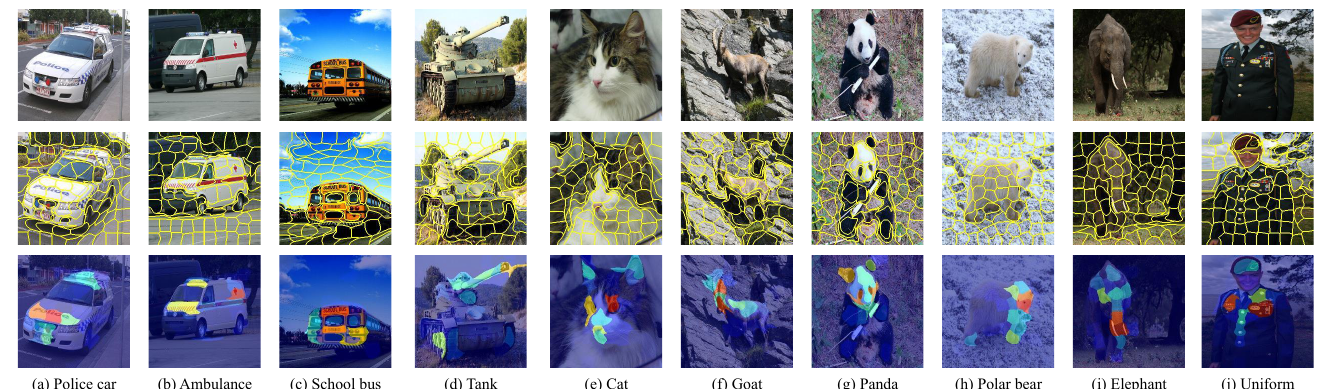
Figure A4. Examples of ground truth result of the relevant feature block marked by the user of each category. ( TOP ) Ten input image samples in ten categories from the evaluation data set DataS. ( Middle ) Segmented image with 100 feature blocks obtained according to the SLIC segmentation algorithm. ( Bottom ) Resulting multi-participants human attention mask. Each image is annotated by 40 unique participants.